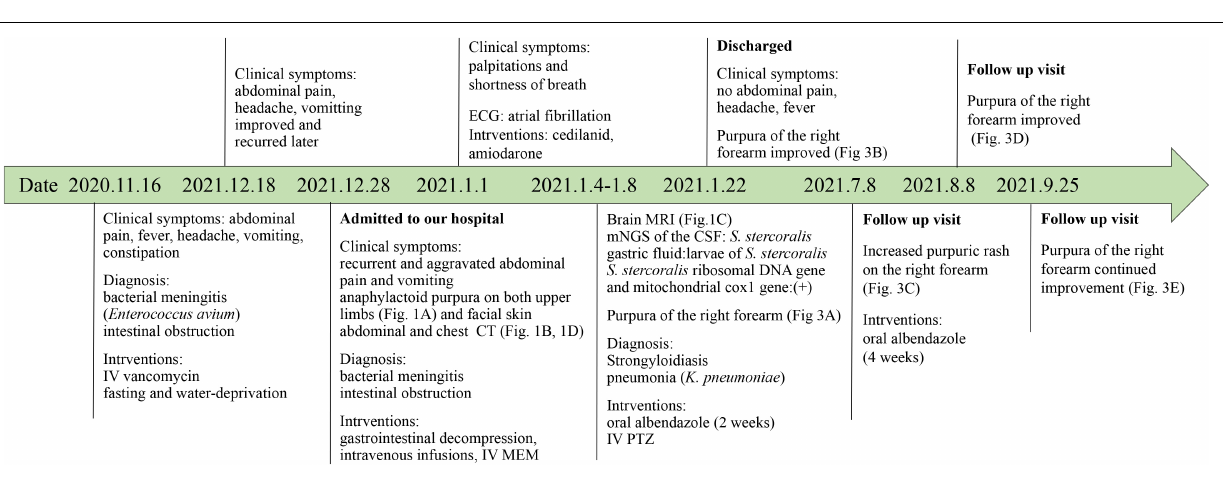
FIGURE 3 | The changes of purpura in right forearm of the patient. Schonlein purpura in his right forearm at admission (A) , after 10 days of treatment (B) , 5 months after discharge (C) , after the second course of treatment (D) , one and a half months after the second course of treatment (E) .